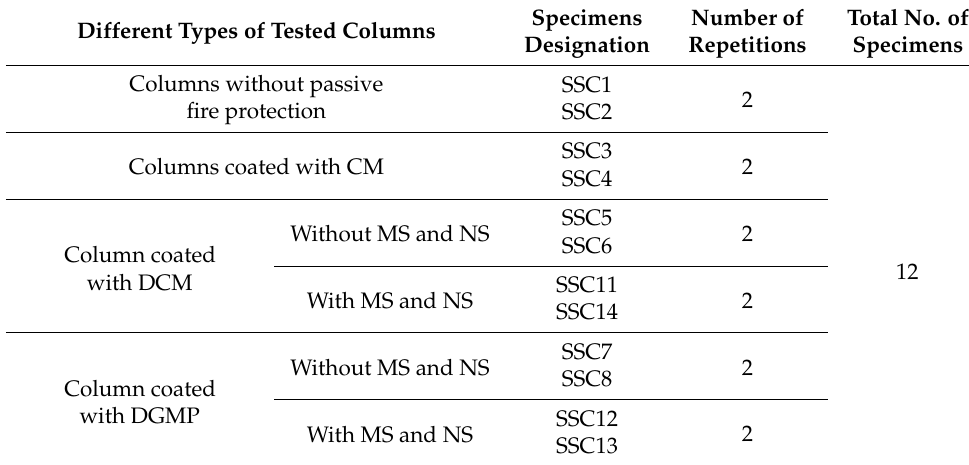
Table 4. Experimental program on short steel columns.